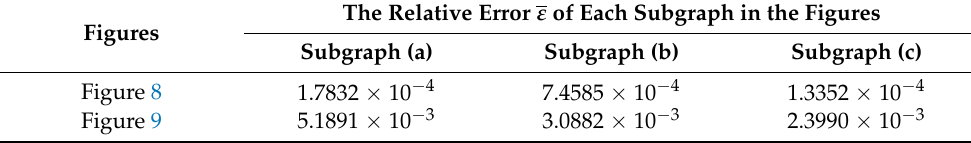
Figure 9. Comparisons of two-degree reduction among GA method, PSO method, and SSA method; under C 0 constraint condition. Table 2. The errors of degree reduction for the comparison in Figures 8 and